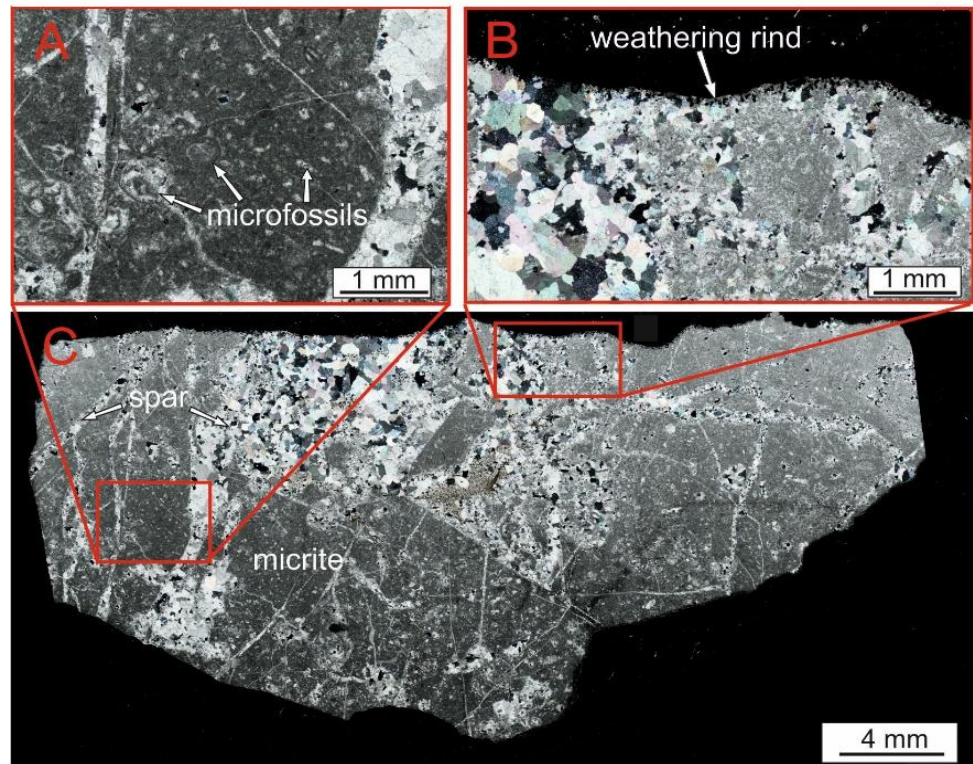
Figure 8. A sample of limestone taken from site 5 (upper surface was glacially abraded in LIA) visible under the optical microscope; ( A )—foraminifera in micrite matrix, ( B )—weathering rind on micrite and spar, ( C )—general view of the samples with numerous micro-fossils, spar veins and micro-cracks.